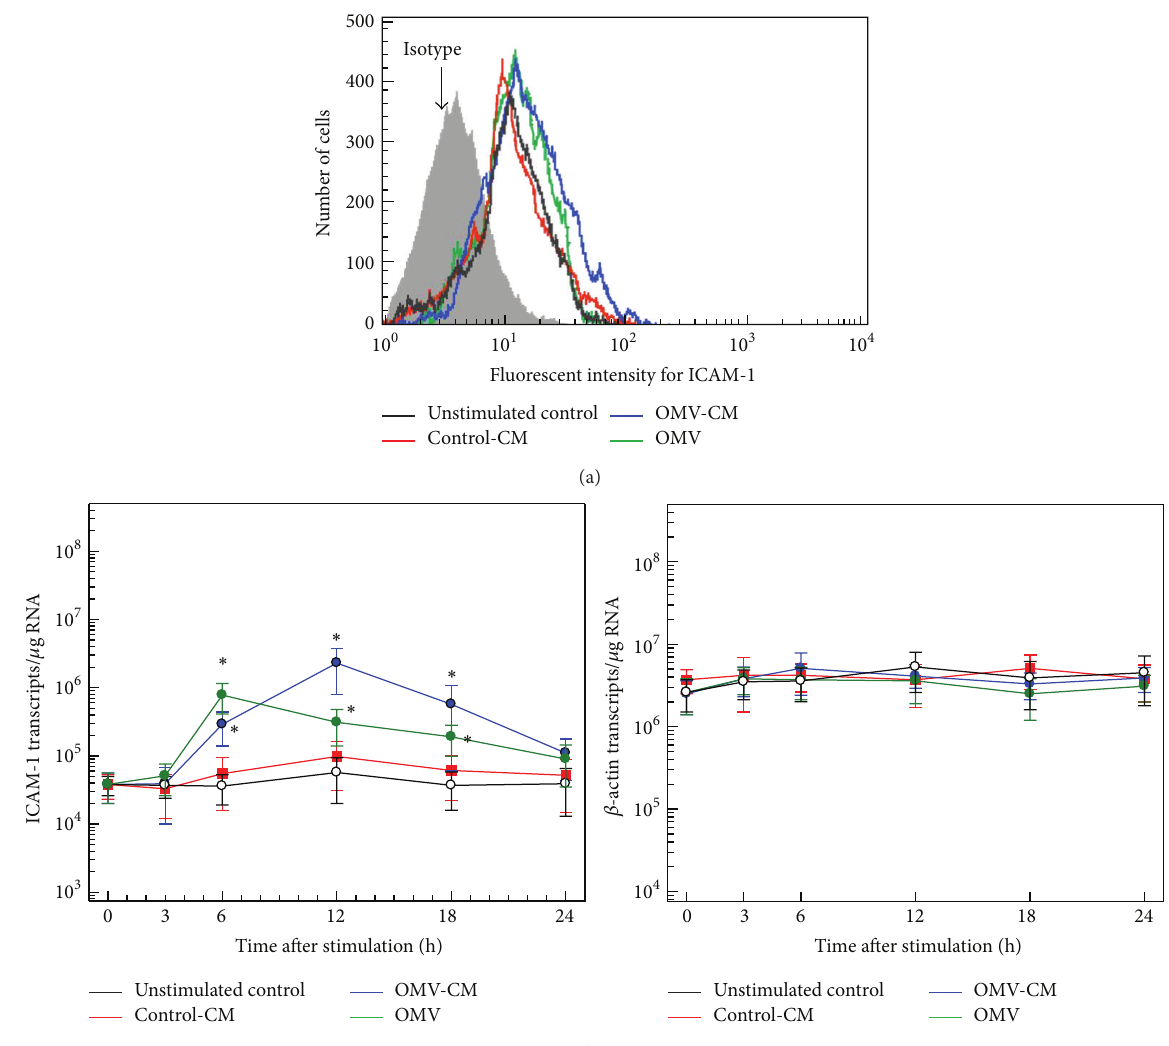
Figure 4: ICAM-1 expression in gastric epithelial cells stimulated with H. pylori OMVs or OMV-induced culture supernatant. (a) OMV-CM and control-CM were prepared as described in Materials and Methods. Primary human gastric epithelial cells were stimulated with OMVs (200 𝜇 g/mL), OMV-CM (50% v/v), or control CM (50% v/v) for 24 h. Cells were stained with a mAb against ICAM-1 and then analyzed using flow cytometry. Results are representative of more than five independent experiments. (b) Time course of ICAM-1 mRNA expression in gastric epithelial cells after stimulation with OMVs, OMV-CM, or control-CM. Cells were stimulated with OMVs (200 𝜇 g/mL), OMV-CM (50% v/v), or control-CM (50% v/v) for the indicated periods of time. The expression levels of ICAM-1 and 𝛽 -actin mRNA were analyzed by quantitative RT-PCR using standard RNAs. Values are expressed as mean ± SD ( 𝑛 = 5 ). Asterisks indicate statistical significance after comparison with unstimulated controls ( 𝑃 < 0.05